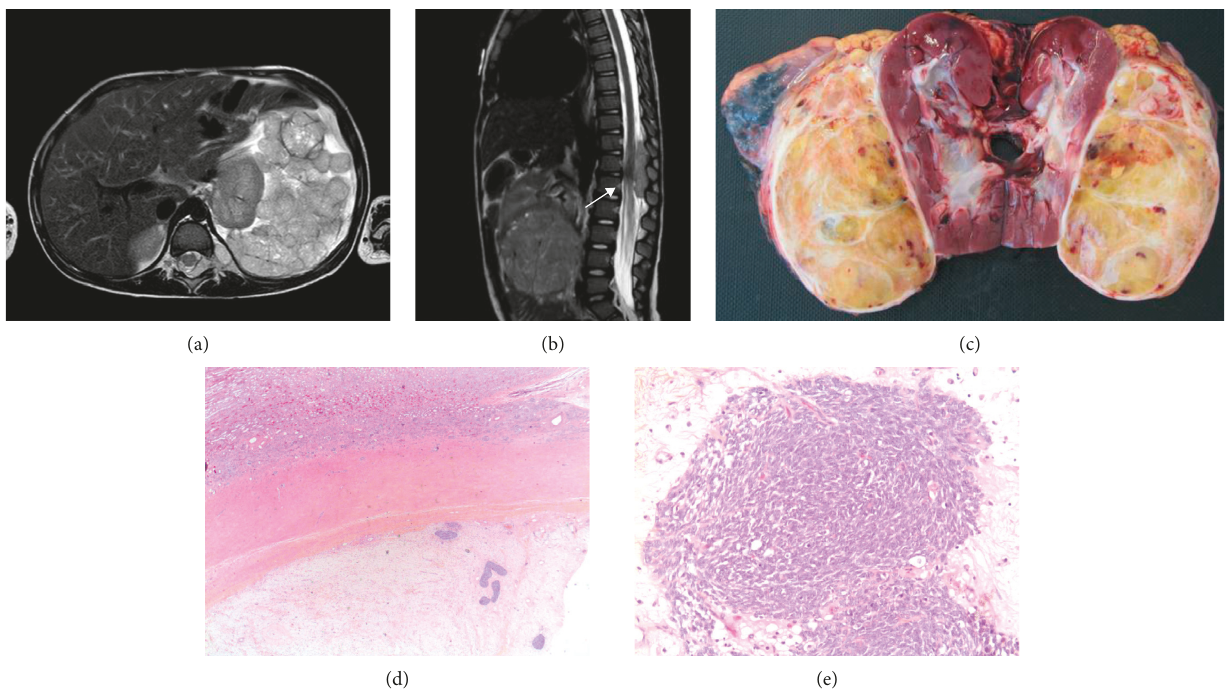
Figure 1: (a) Magnetic resonance imaging (MRI) showed an encapsulated tumor, with signs of capsular effraction at the upper pole of the left kidney. (b) Magnetic resonance imaging (MRI) showed a tumor, forming an intraspinal mass from T11 to L1 and compressing the spinal cord (arrow). (c) The left nephrectomy presented macroscopically a large tumor attached to the kidney without renal infiltration. (d) The microscopical examination confirmed the separation between the tumor and the kidney (Hematein-Eosin-Safran, × 100). (e) Wilm’s tumor, with regressive changes, of intermediate risk with only small areas of blastema (Hematein-Eosin-Safran, ×